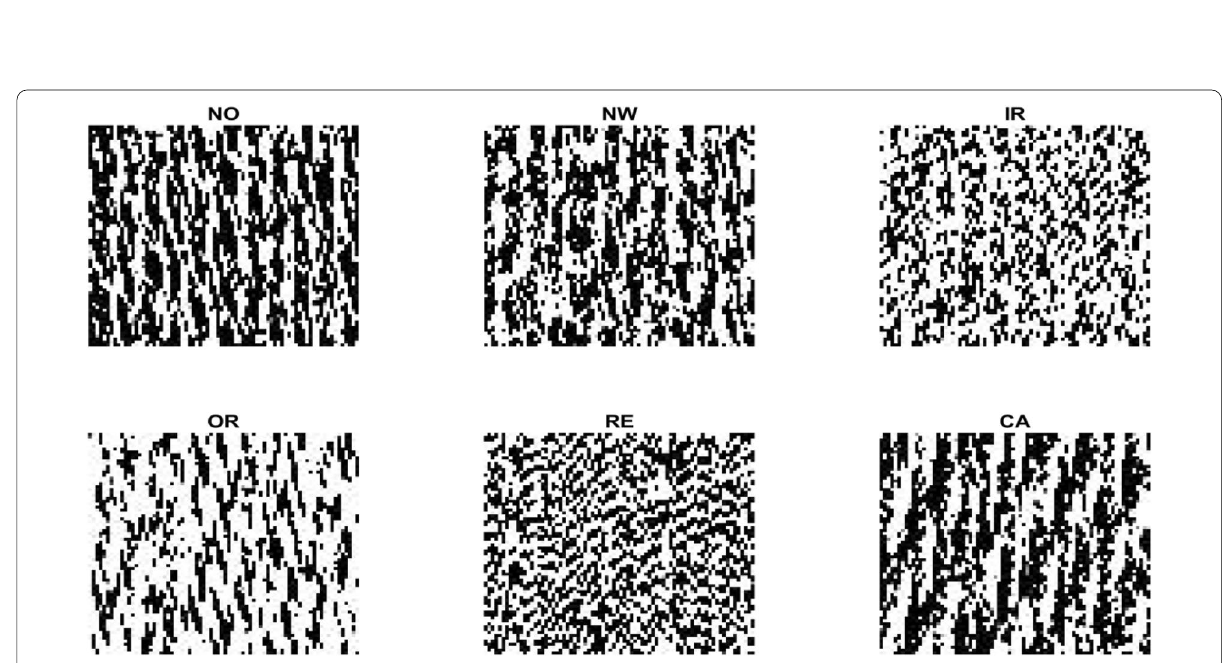
Figure 9 Typical examples of the obtained 2-D grayscale image for the six different health conditions of the first case